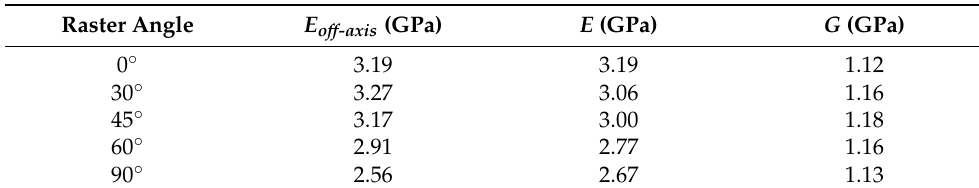
Table 5. Material constants with different raster angles.